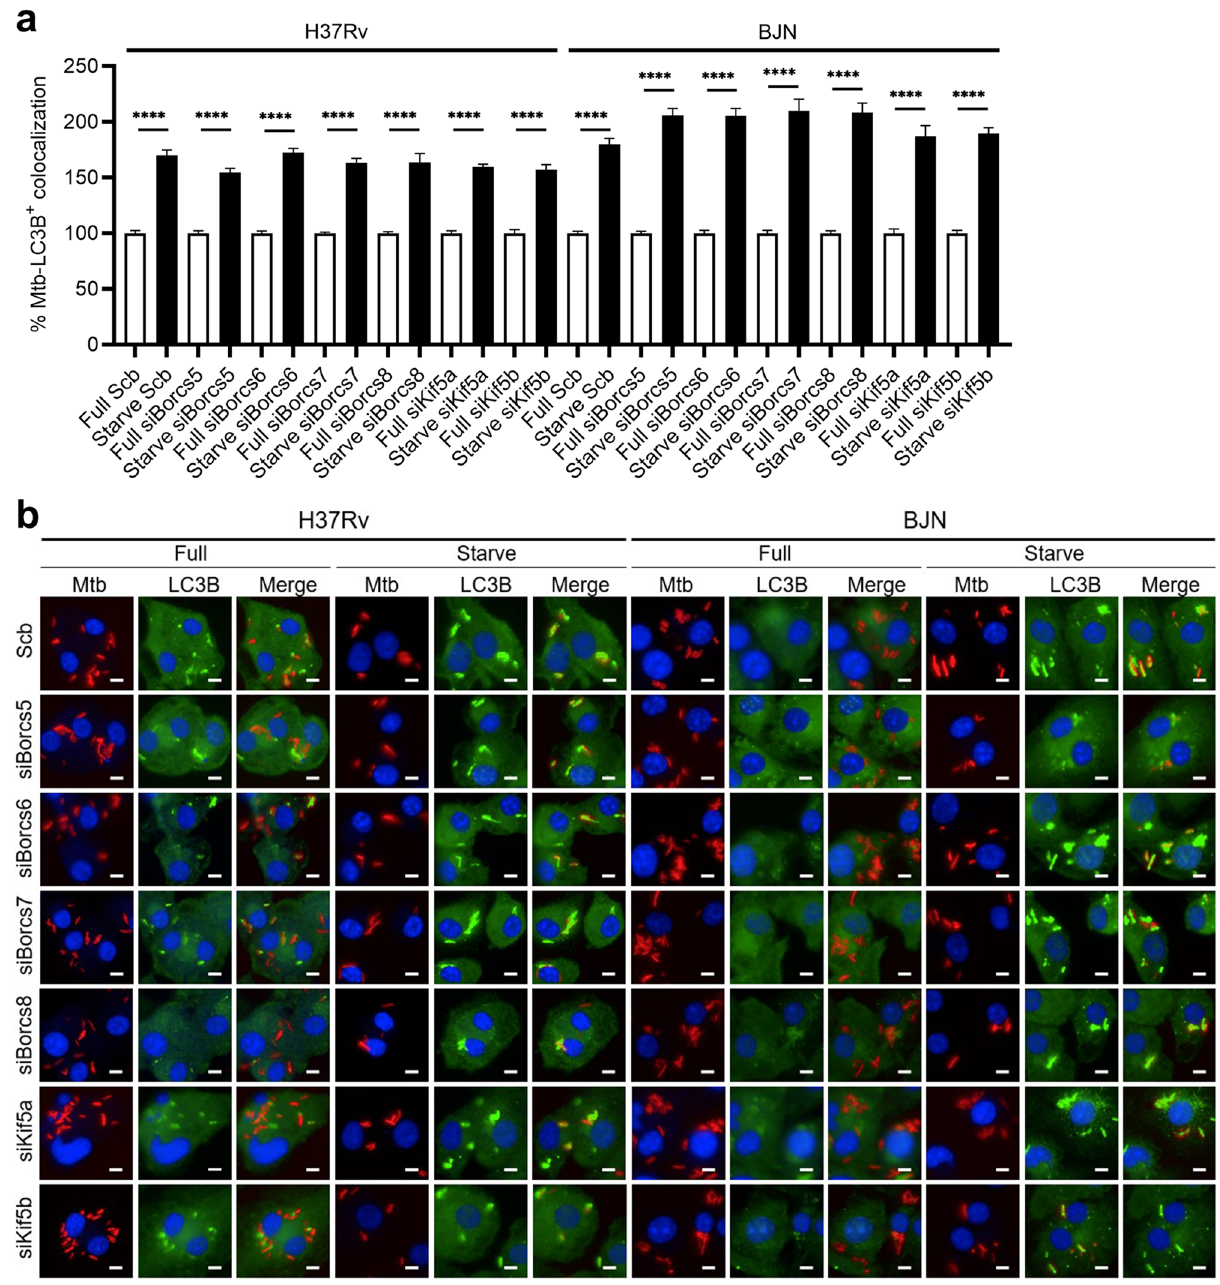
Figure 6. BORCS5-8 and Kinesin-1 are not involved in the BJN delivery to the autophagosomes. ( a,b ) BMDMs deficient in BORCS5-8 and Kinesin-1 expressions were infected with the mCherry-expressing H37Rv or BJN (MOI = 10) for 15 min and chased for 1 h followed by autophagy induction by starvation for 2 h. Cells were fixed and stained with anti-LC3B antibody and Hoechst. Percent mycobacteria-LC3B colocalisation was then analysed by high-content image analysis. Data are means ± SEM from at least three independent experiments; ****p < 0.0001, relative to the full control set of 100% determined by one-way ANOVA with Tukey’s multiple comparison test ( a ). Representative images are displayed in ( b ). Bar 5